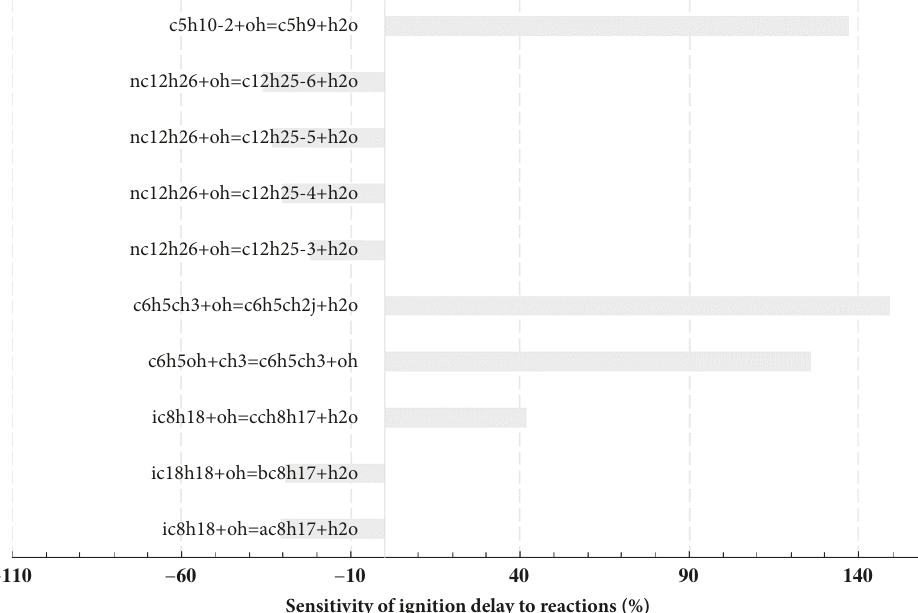
Figure 21: Sensitivity analysis for total ignition delays for prediction of ignition under constant-volume conditions at initial conditions of 715 K, 40 bar, and fuel-air equivalence ratio of